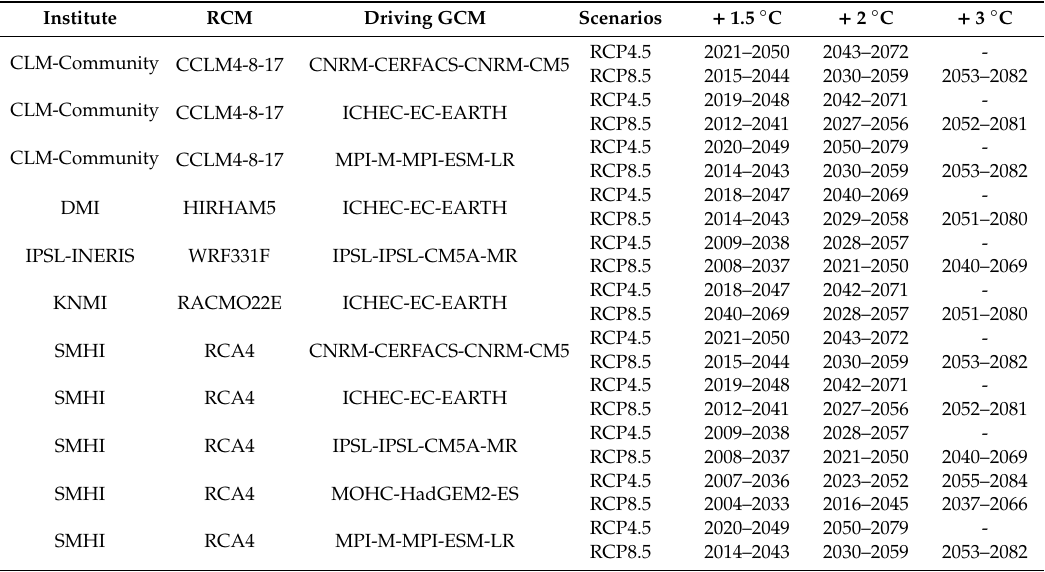
Table 1. Regional climate model (RCM) simulations used in this study with 30-year time ranges when the driving general circulation model (GCM) projects a global 1.5, 2 and 3 ◦ C warming according to IMPACT2C